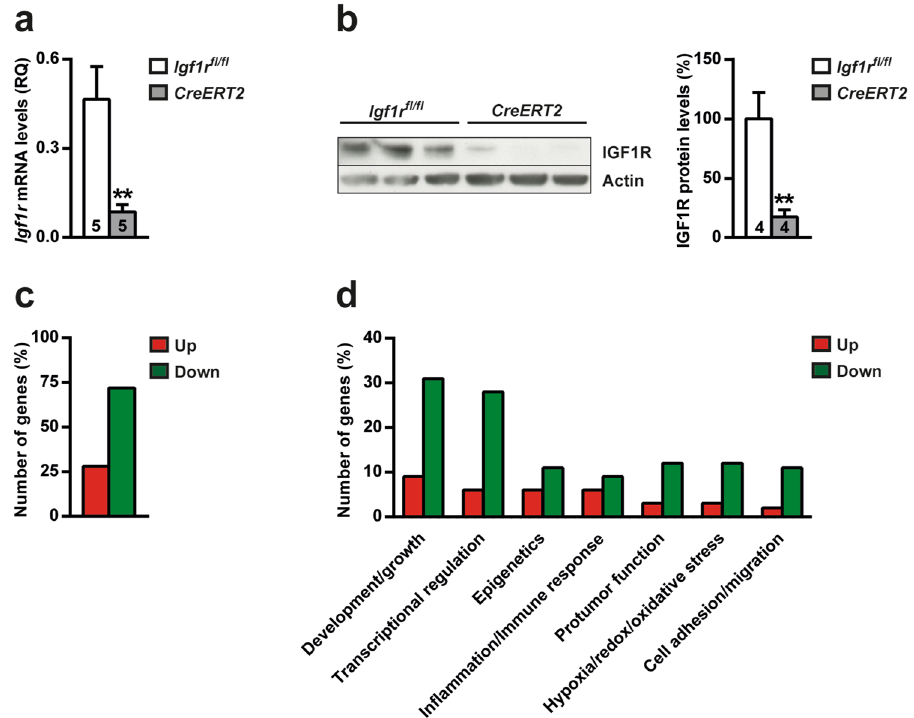
Figure 1. Decreased IGF1R expression levels and changes in the lung transcriptome of prepubertal IGF1R - deficient mice. ( a ) Igf1r mRNA expression levels and ( b ) representative Western blots for IGF1R and graphical representation of densitometric measurements of band intensities (percentage) normalized to beta-Actin levels and quantified in eight-week-old UBC-CreERT2 ; Igf1r fl / fl ( CreERT2 ) mice with respect to controls ( Igf1r fl / fl ). ( c ) Number of differentially expressed genes (percentage) found with significant changes (FDR < 0.1) in the lungs of UBC-CreERT2 ; Igf1r fl / fl ( CreERT2 ) mice (n = 3), and ( d ) representation of the percentage of Igf1r - transcriptionally regulated genes involved in reported biological functions. Bars are color-coded in red and green for up- and down-regulated genes (respectively). Numbers within graphic bars indicate the number of mice analyzed and data are expressed as mean ± SEM. ** p < 0.01 (Mann-Whitney U test). Up, up-regulated; Down,